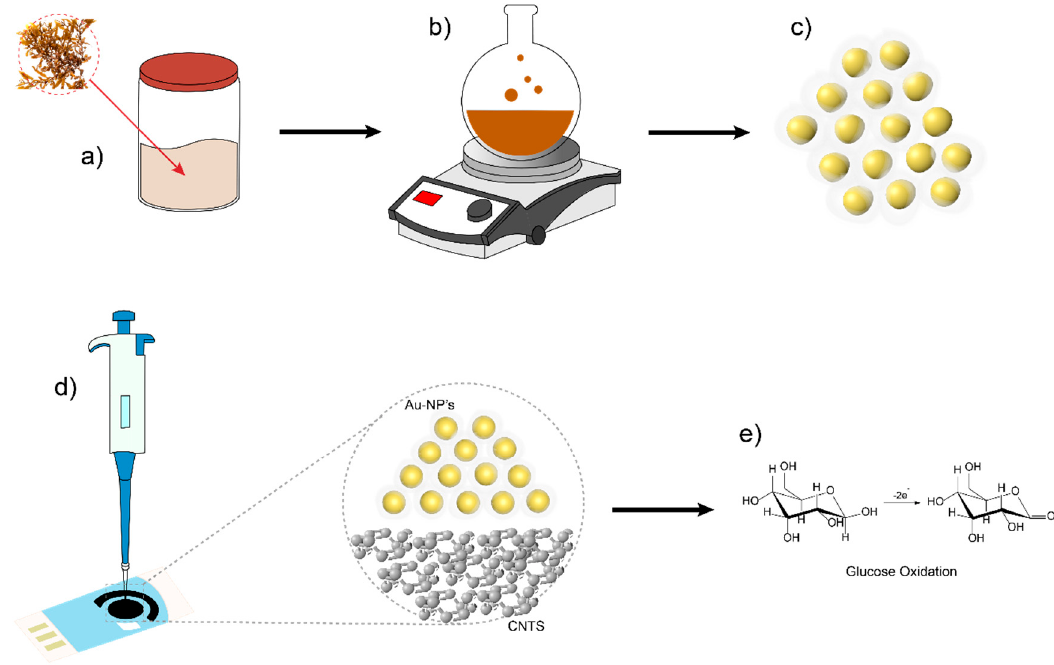
Figure 2. Electrode modification pathway by drop-casting technique using green synthesis AuNPs from Ssp for the assembly of a sensor with carbon nanotubes-screen printed electrodes (CNT-SPE) for glucose detection and quantification. ( a ) Extract of Sargassum sp. by infusion method. ( b ) Green synthesis of AuNPs using Ssp extract. ( c ) AuNPs with an organic capping from Ssp compounds. ( d ) Drop-casting of AuNPs on CNT-SPE electrode and their interaction. ( e ) Semi-reaction of glucose oxidation on the CNT-SPE modified with AuNPs.